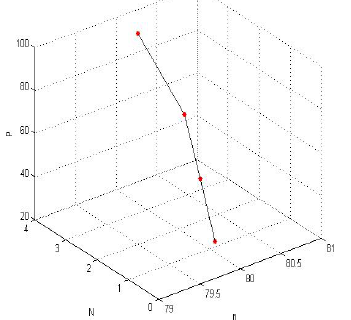
Figure 4 – A 3D graphic presentation for the password length of n = 80 bits Рис . 4 – 3 Д графическое изображение пароля размером n = 80 битов Слика 4 – 3 Д графичка презентација за лозинку дужине n = 80